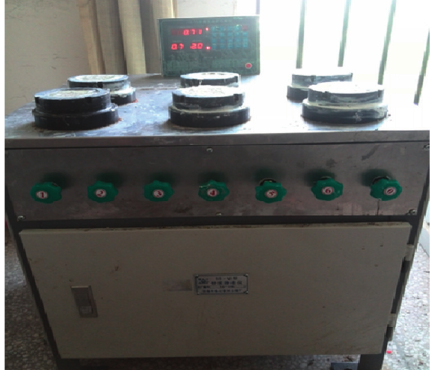
Figure 4: Antipenetrability performance test of sisal fiber rice husk Table 4: Experimental results of test blocks.